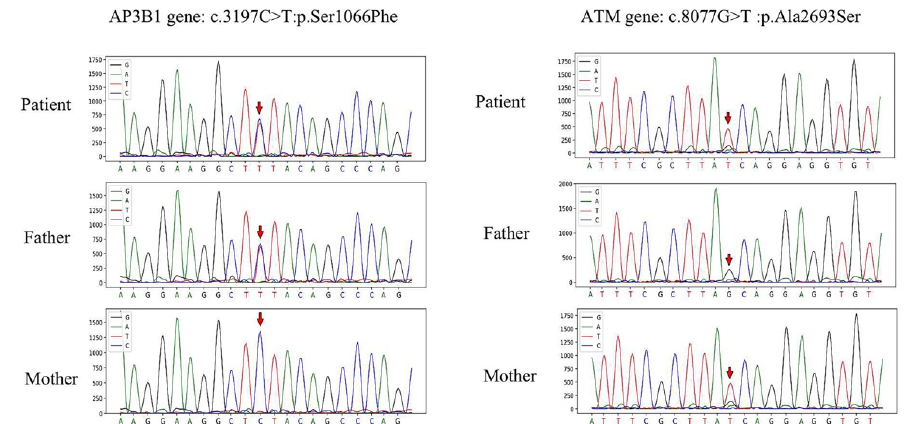
Figure 5. The mutation sites in this patient include the AP3B1 variant c.3197C > T and the ATM gene c.8077G > T, both of which are newly identified variants, the former from the father and the latter from the